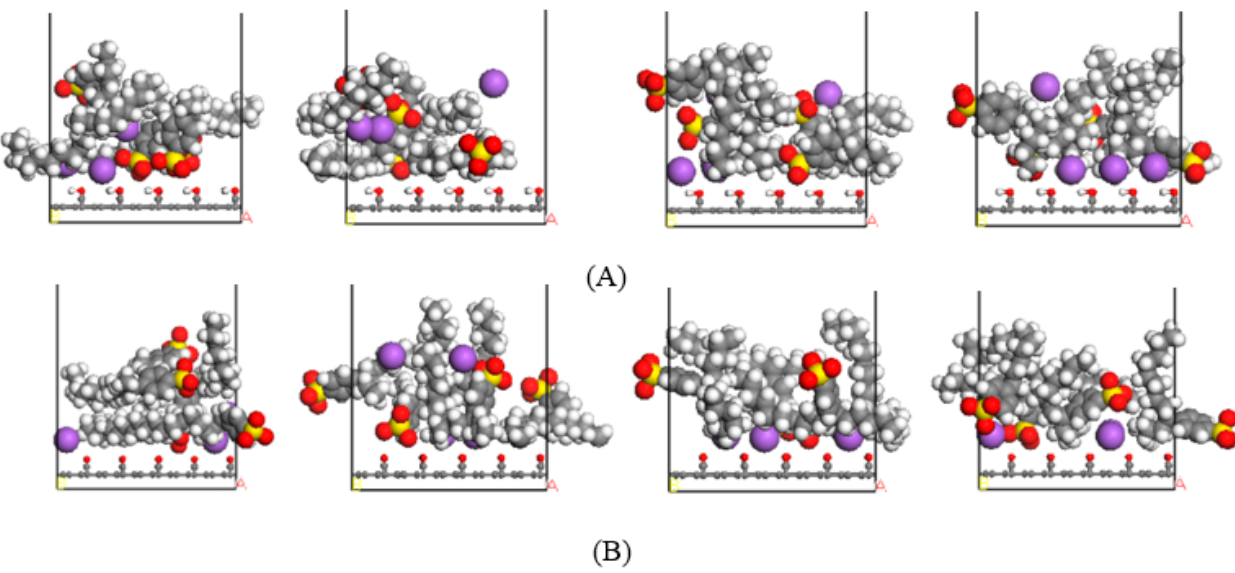
Figure 7. From left to right is the m-C16/anthracite system (m = 2,4,6,8). ( A ) The final adsorption configuration after equilibrium on the hydroxyl-modified graphite layer; ( B ) the final adsorption configuration after equilibrium on the ketone-modified graphite layer (the purple spheres represent sodium